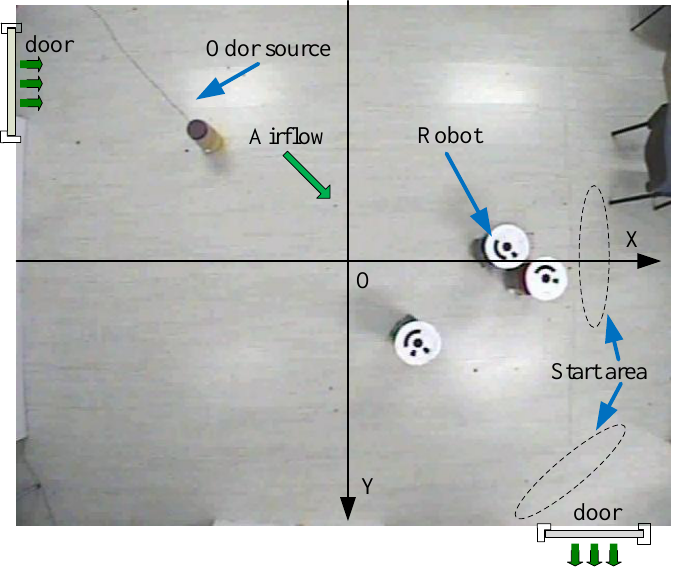
Figure 12. Real-robot experiment arena as seen from the overhead